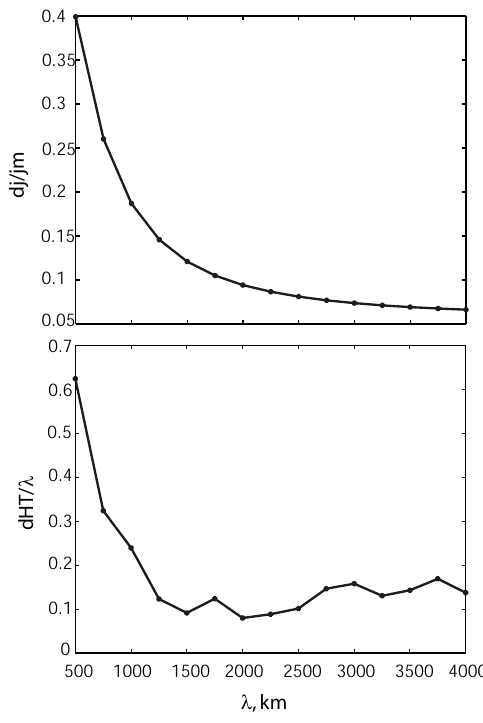
Fig. A3. Relative errors of current density (upper panel) and the cur- rent sheet half-thickness (bottom panel) estimates versus the model sheet